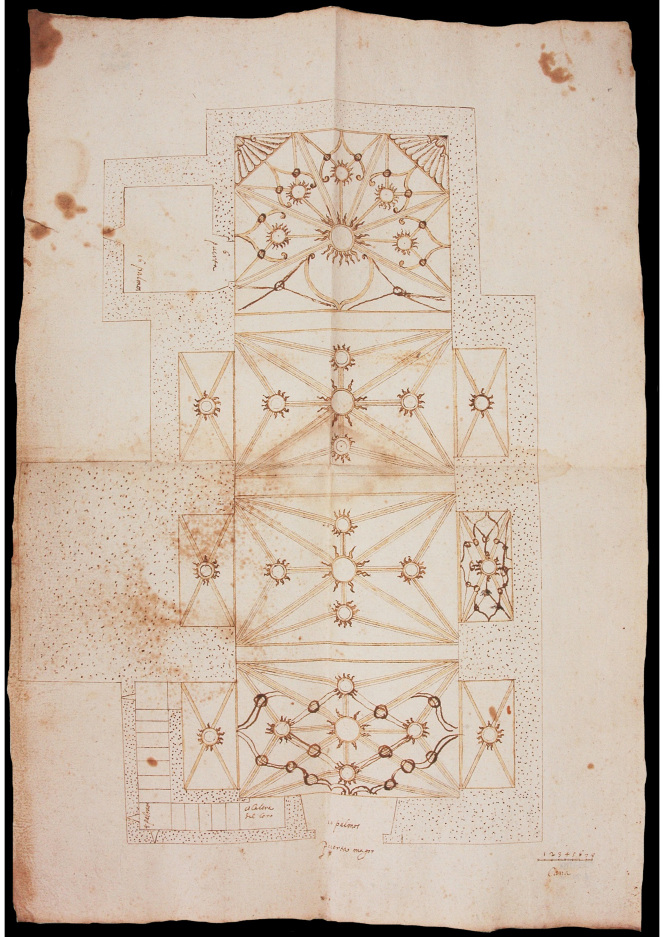
Figure 18. Project for the parish church of Palo (Huesca) [A.H.P.HU., ES/AHPHU-MPGD/1/6]. © Archivo Histórico Provincial de Huesca. These formulas came to coexist with coffered vault decorations of an anti- quarian nature. Indeed—and this should be emphasized—when the latter had to